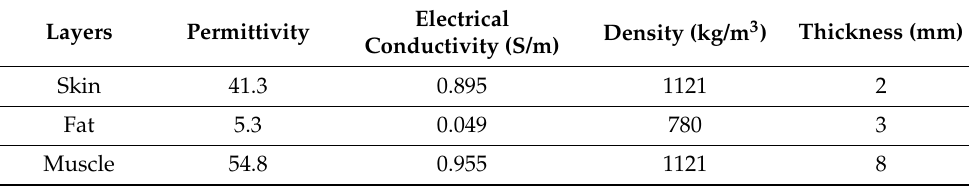
Table 3. Different human tissues’ properties [25].